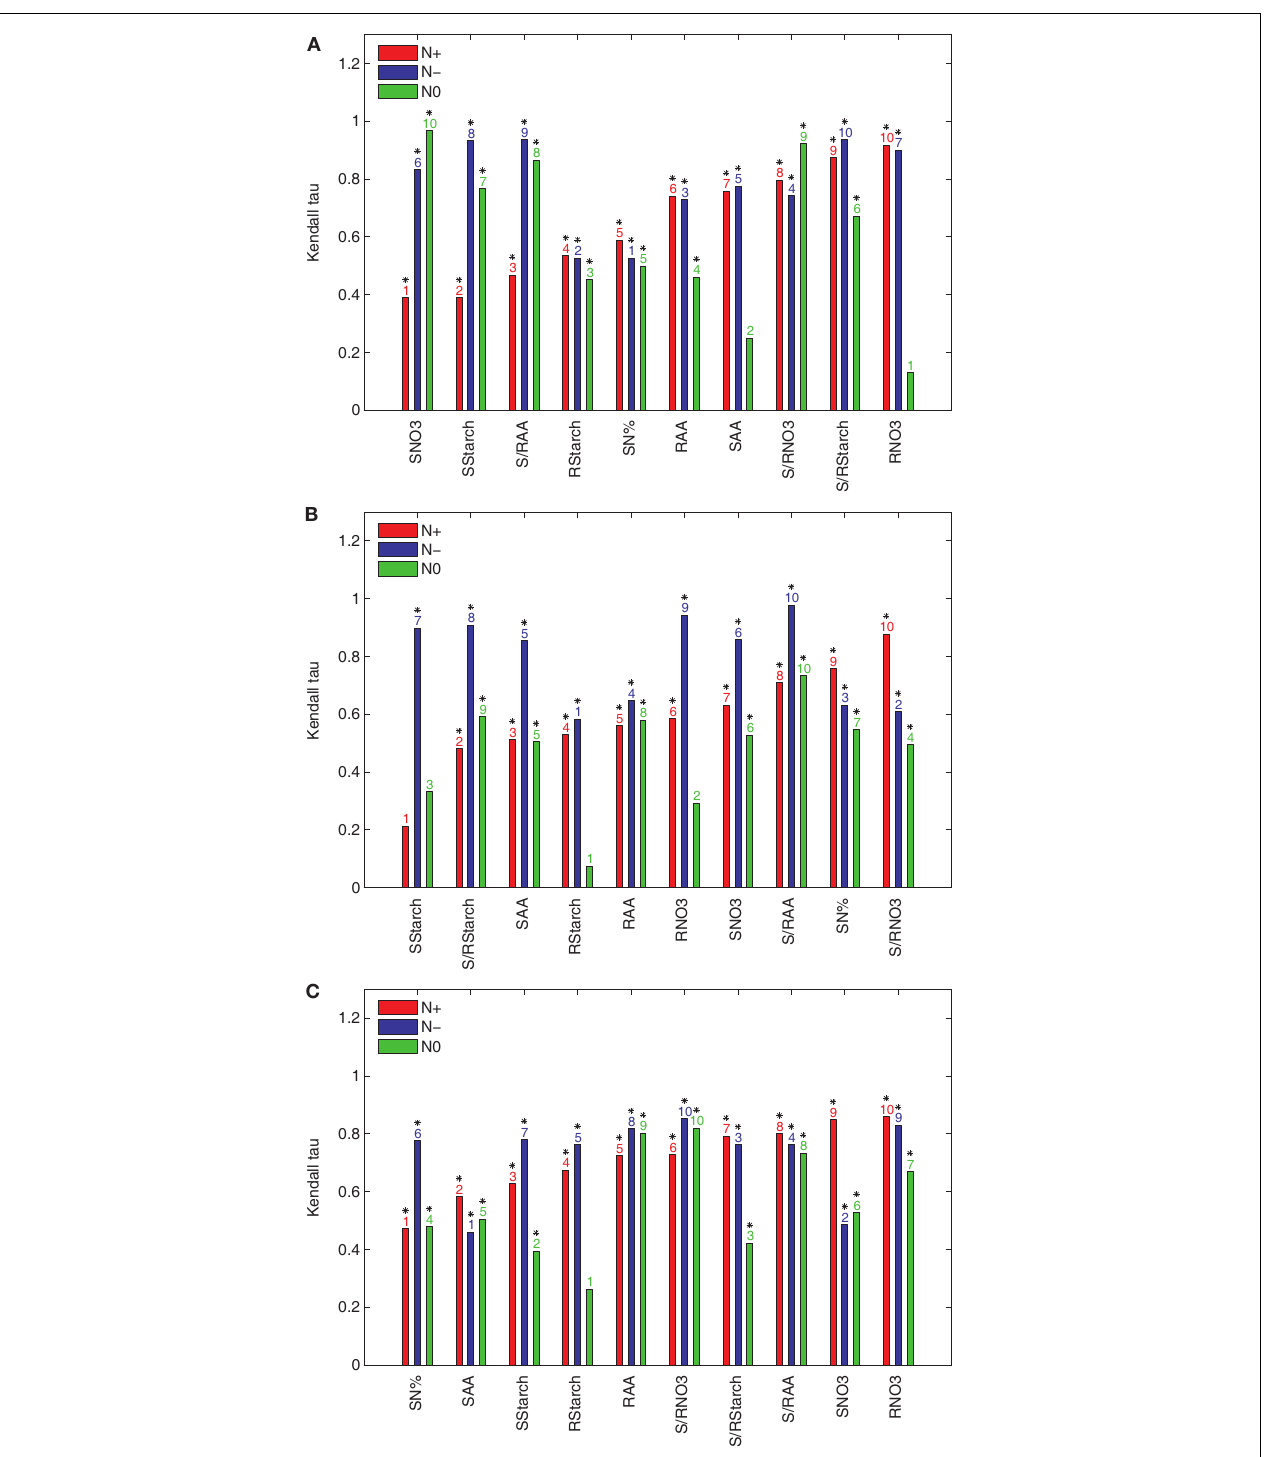
Kendall τ coefficients with respect to their effect in the N + condition.The y -axis shows the Kendall τ coefficients belonging to a particular metabolic trait under normal nitrogen (N + , red), limited nitrogen (N − , blue), and starved nitrogen (N0, green) supply.The ordering of metabolic traits for the different nitrogen availabilities is indicated above the bars. Significant Kendall τ correlation ( p -value < 0.05) is marked with a black star above the bar